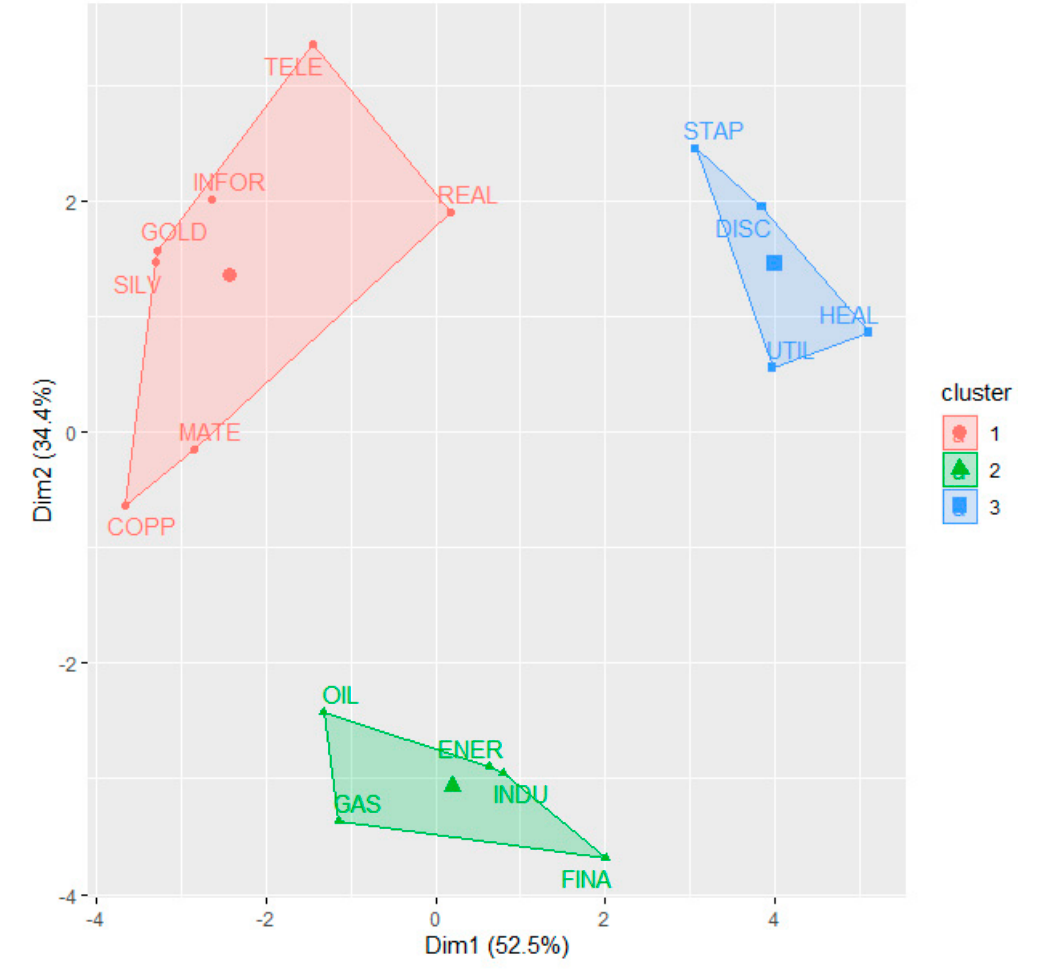
Figure 6. Cluster analysis results for time scale 6.